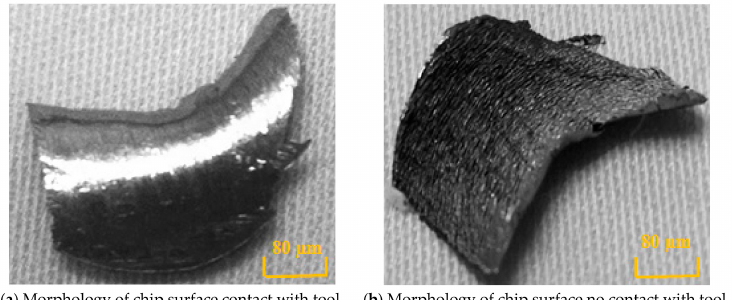
Figure 10. Segmented chips of gray cast iron.